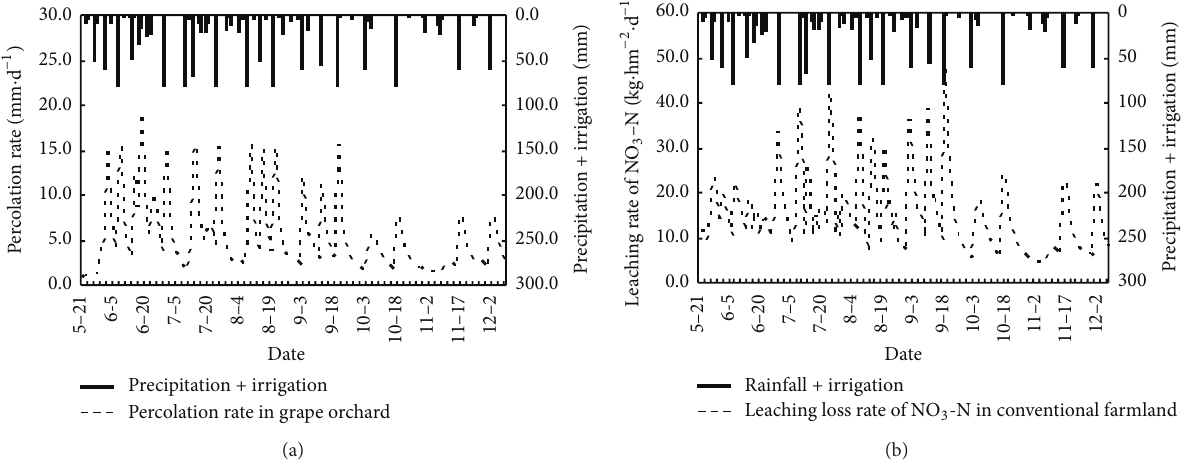
Figure 6: Variation curves of soil water percolation rate and NO 3 -N leaching loss rate with date in intensive grape orchard.